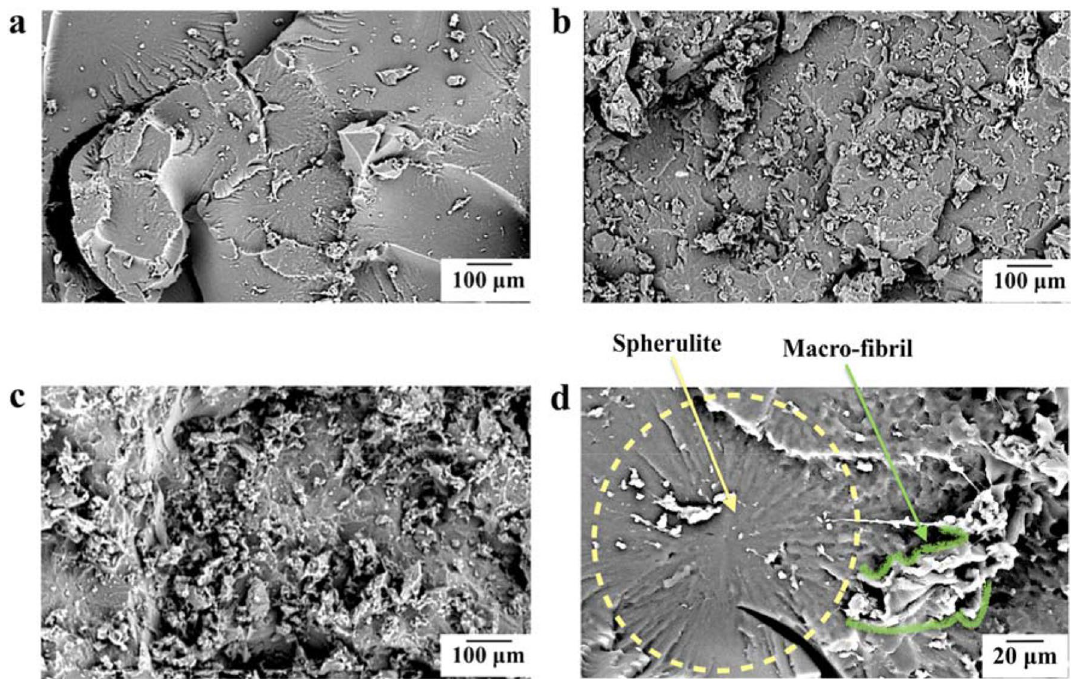
Figure 2. SEM fractographies of spalled surface: (a) neat PU; (b) nanocomposite without silane terminations; (c) HNT-PU nanocomposite. In (d) , we show the neat PU again at a different magnification, with a spherulite and macro-fibril highlighted. (a) is reproduced from 27 under license CC BY